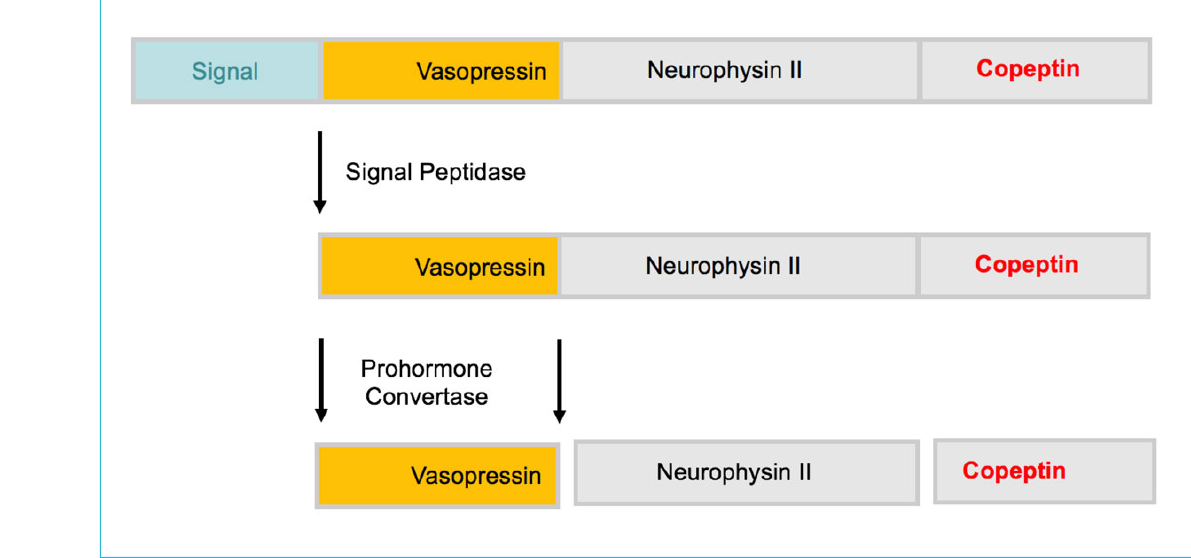
Figure 1: Structure of prepro-vasopressin-neurophysin II. The prohormone is packaged into neurosecretory granules of magnocellular neu- rons. During axonal transport of the granules from the hypothalamus to the posterior pituitary, enzymatic cleavage of the prohormone gener- ates the final products: Vasopressin, neurophysin II and the COOH-terminal glycoprotein